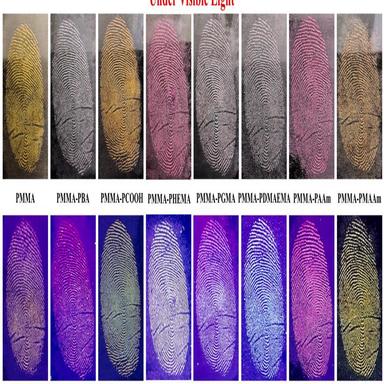
Dual-mode visualization of latent fingerprints using of photoluminescent polymer nanoparticles and powder dusting method.